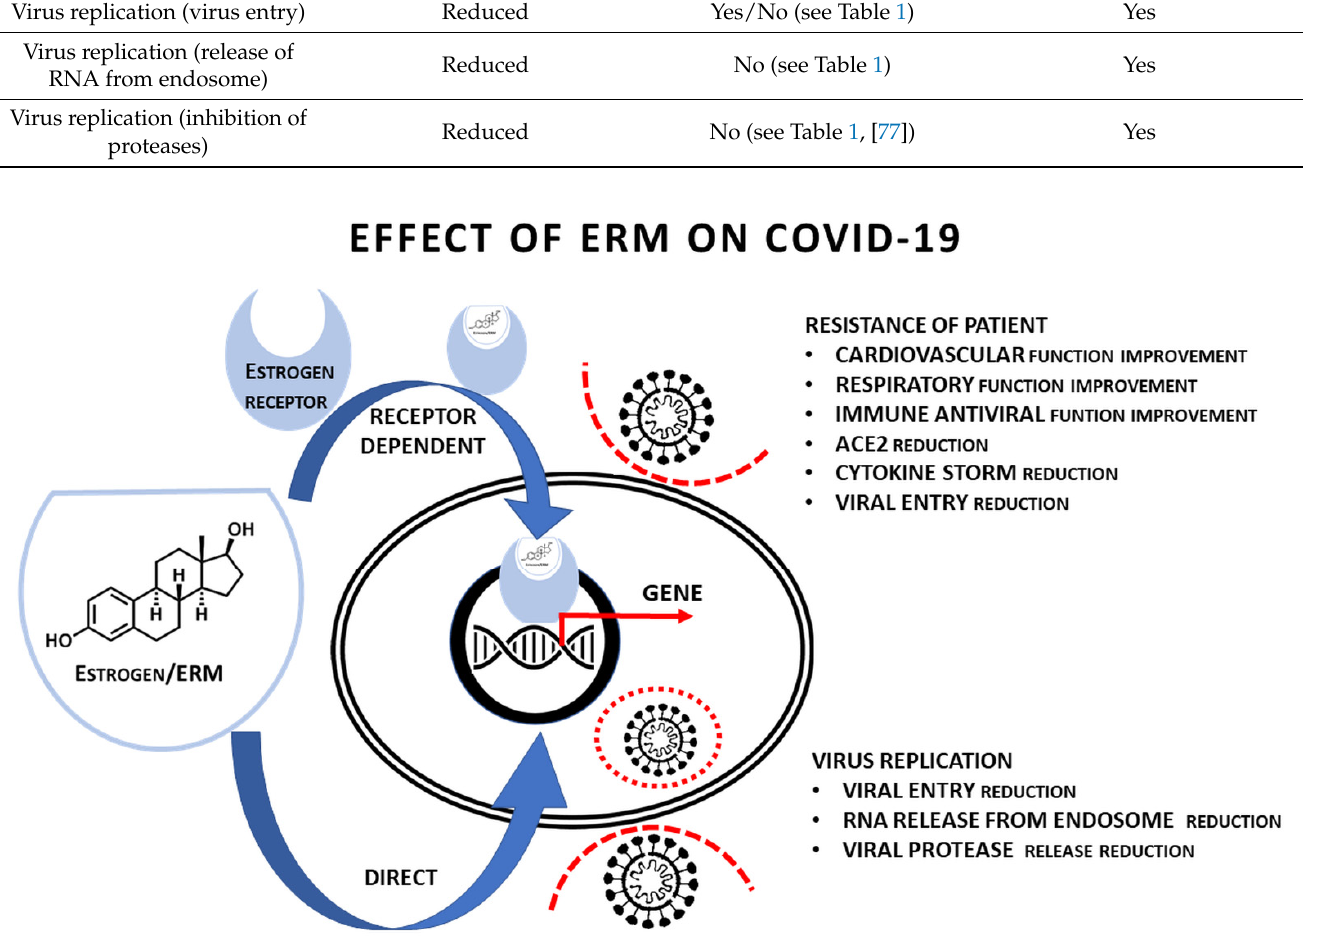
Figure 7. Schematic presentation of the proposed receptor-dependent and independent effect of ERMs on the SARS − CoV − 2 infection.